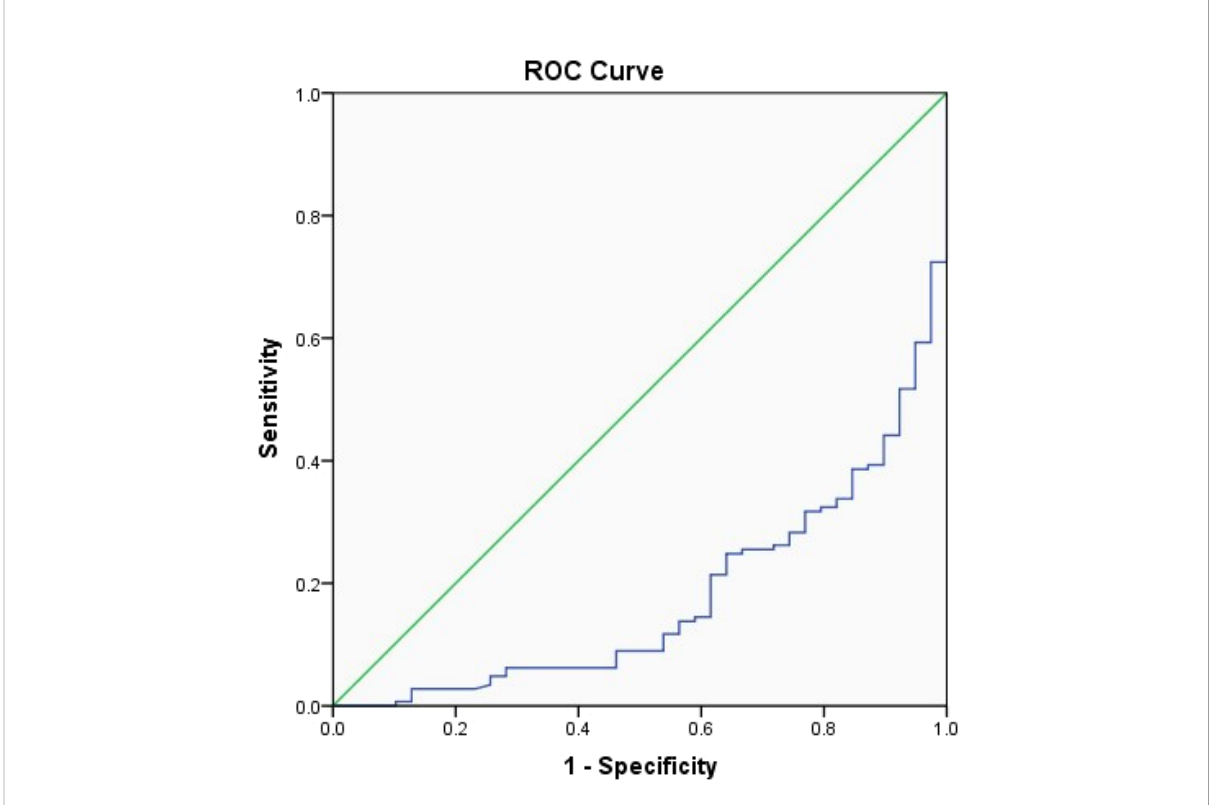
FIGURE 2 The receiver operating characteristic (ROC) curve of LCR to classify COVID-19 patients into moderate, severe, and critical